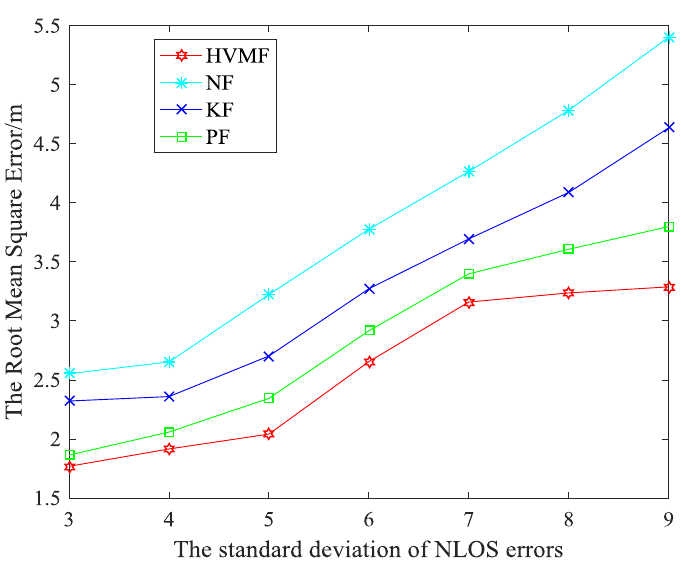
Figure 12. The standard deviation of NLOS errors versus RMSE.